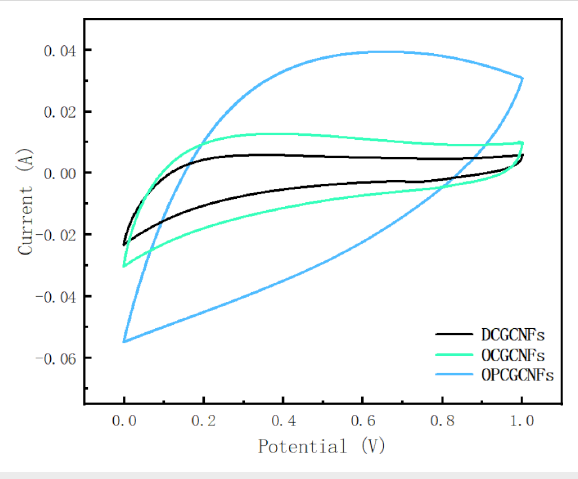
Figure 5: CV curves of the CGCNF electrodes at a scan rate of 25